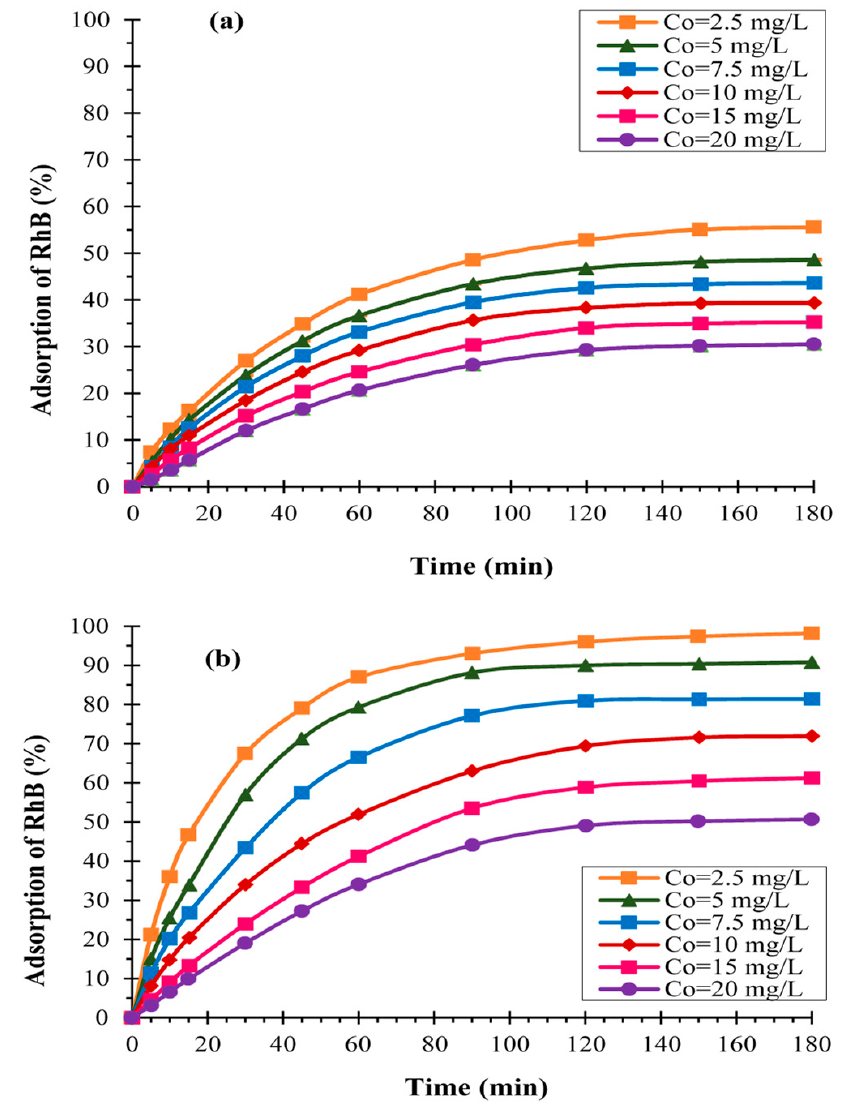
Figure 1. Evolution of the adsorption of RhB dye (%) at different initial concentrations on ( a ) KS44-0 and ( b ) KS44-20 (T = 20 ◦ C, pH = 3 and time = 3 h). Additionally, morphological and structural analyses of carbon composite materials, as well as information pertaining to their surfaces, showed that KS44-20 had a more significant porous structure than that that of KS44-0 (Figure 2a,c). The pore shape difference between KS44-0 and KS44-20 was well-illustrated by scanning electron microscopy, BET the surface areas and mercury porosimetry studies (Table 1)